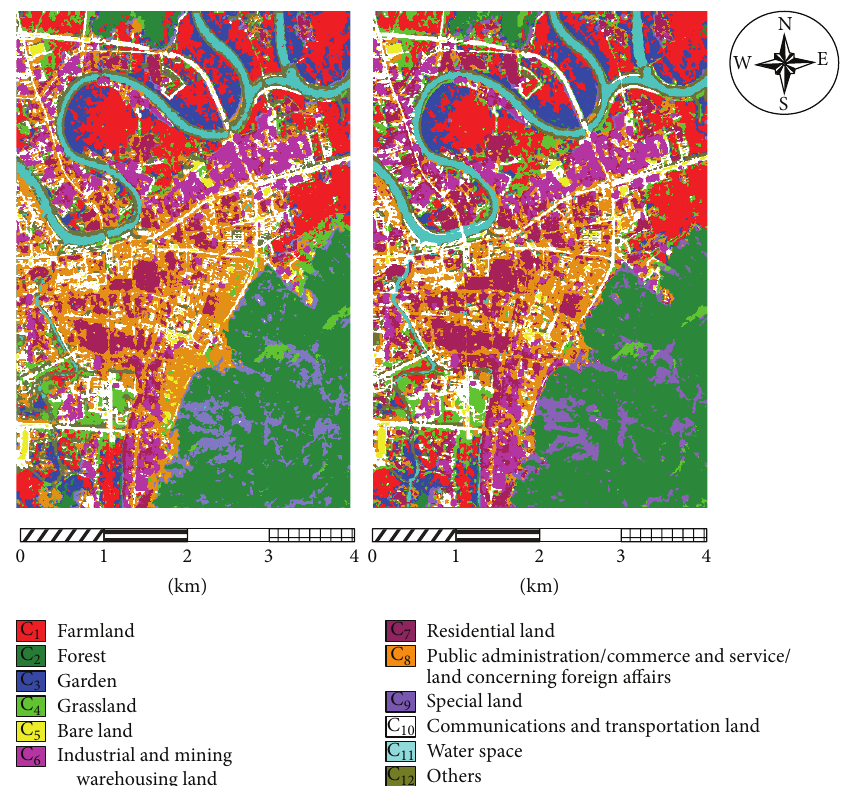
Figure 9: Comparison of BDT-SMO classification based on SRBF and CRBF (zone